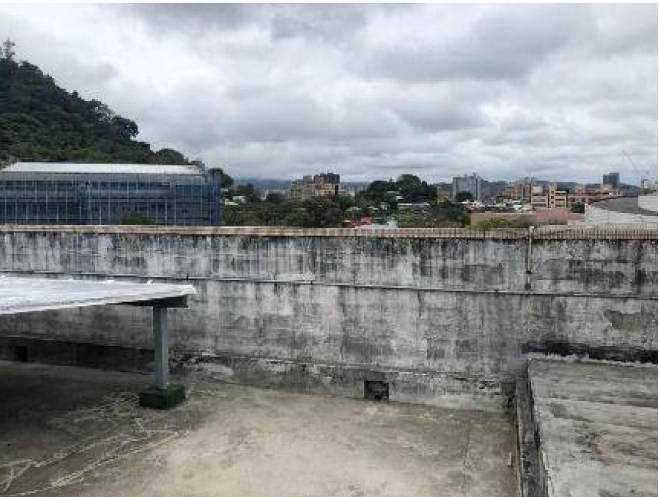
Figure 4. The rooftop of the experimental field.